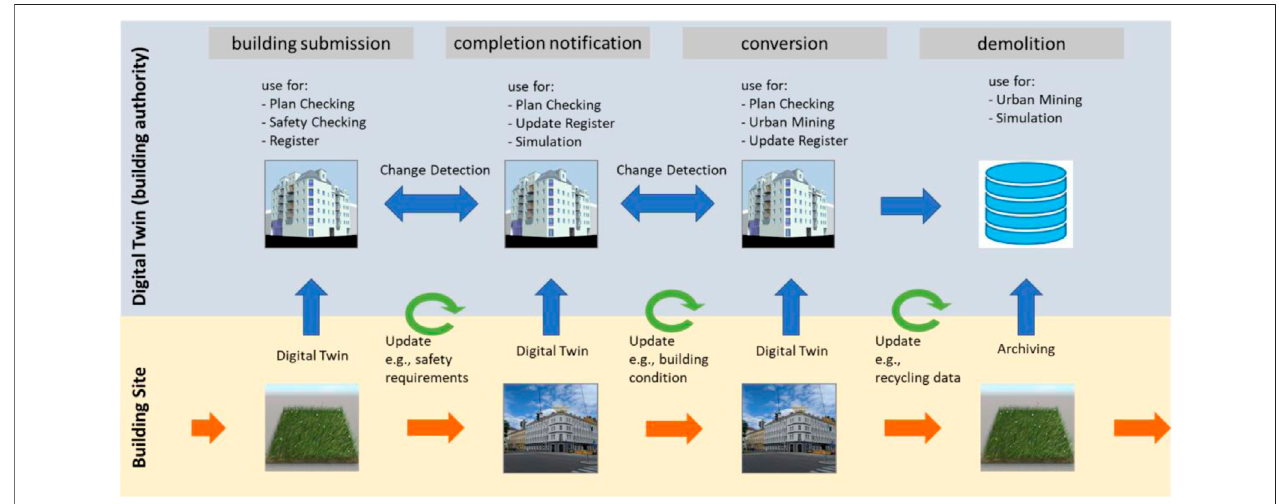
FIGURE 4 | City authority ’ s usage of Digital Twin throughout the construction